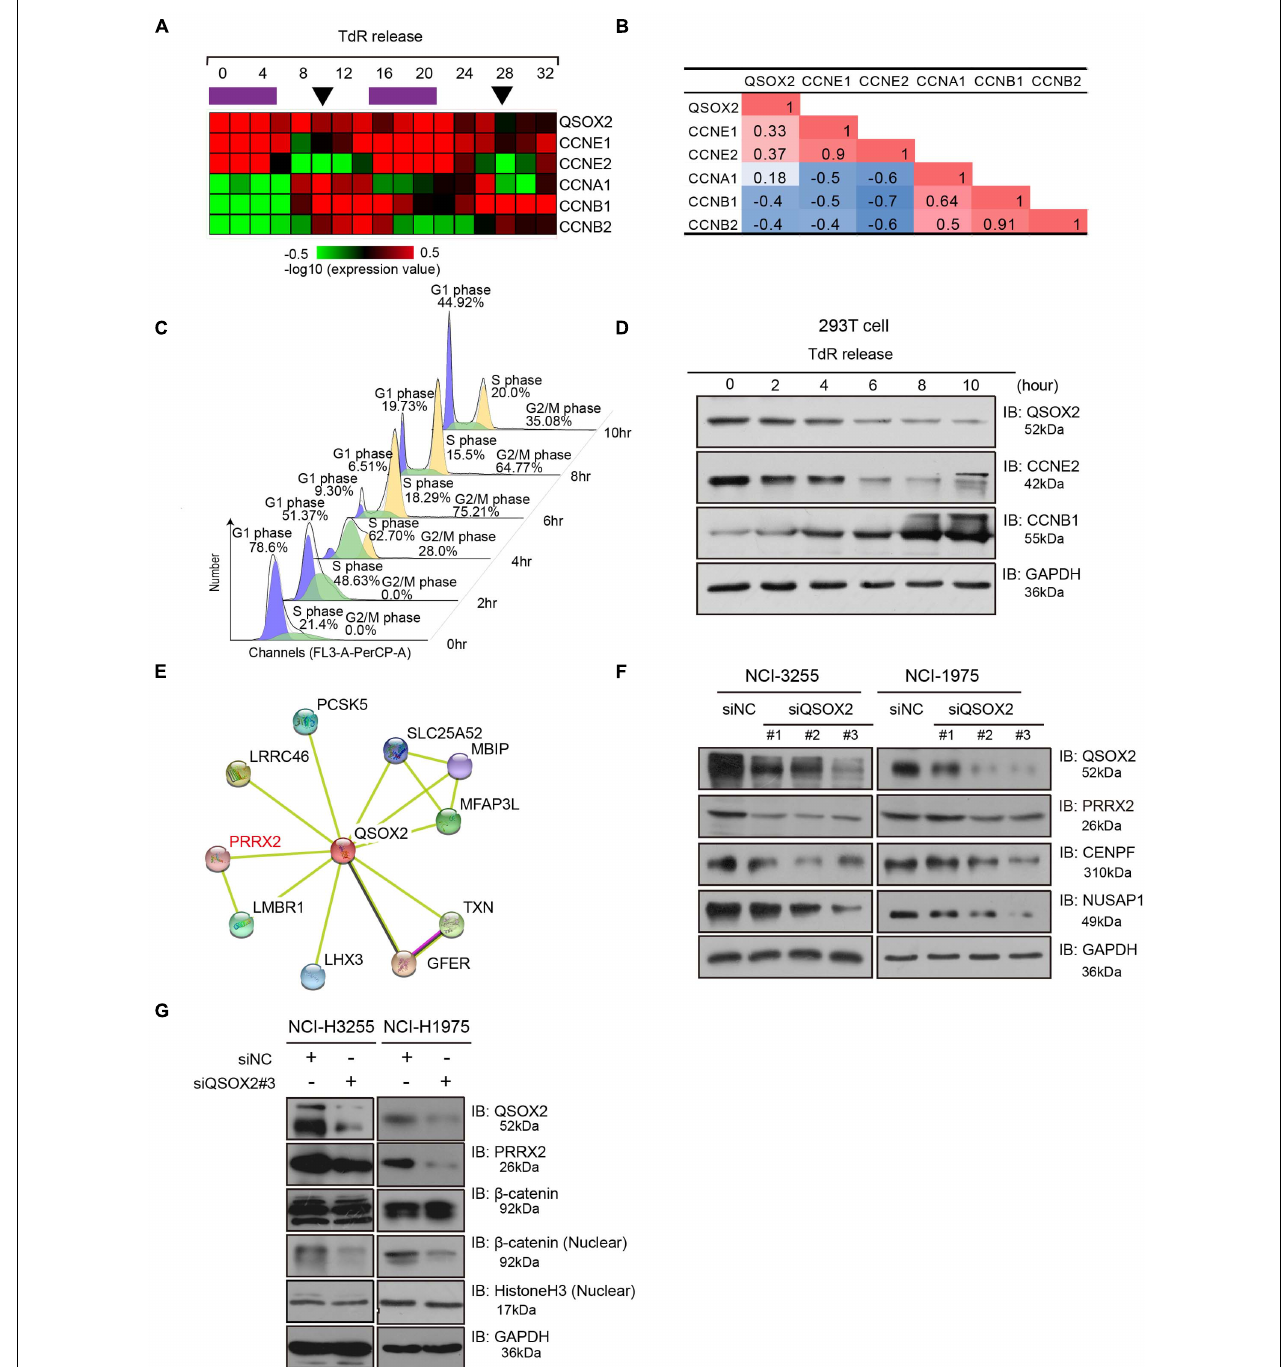
FIGURE 4 | Quiescin sulfhydryl oxidase 2 ( QSOX2 ) is periodically expressed during the cell cycle. (A) Bioinformatic data analysis of GSE52100. Expression heatmap of QSOX2 and cyclin genes in two cell cycle courses after double thymidine block release. The purple bars indicate S phase, and the black arrows indicate mitosis. (B) Correlation analysis between QSOX2 and cyclin gene expression; red: positive correlation; blue: negative correlation. (C) 293T cells synchronized with a double thymidine block, released and evaluated at several time points. The cell cycle profiles were assessed by flow cytometry after propidium iodide (PI) staining of DNA. (D) The expression of QSOX2 and cyclin genes in the cell lysates from panel (C) assessed by Western blot analysis. (E) Protein–protein interaction network (PPI) analysis of QSOX2 assessed by STRING (http://string-db.org/) (F) WB analysis of NCl-H3255 and NCl-H1975 cells transfected with siRNA-control or siRNA- QSOX2 (48 h) and evaluated with the indicated antibodies. (G) Immunoblotting of β -catenin in the nuclear extracts of NCl-H3255 and NCl-H1975 cells was carried out after QSOX2 silencing, and GAPDH and Histone 3 were used as a loading controls, respectively.